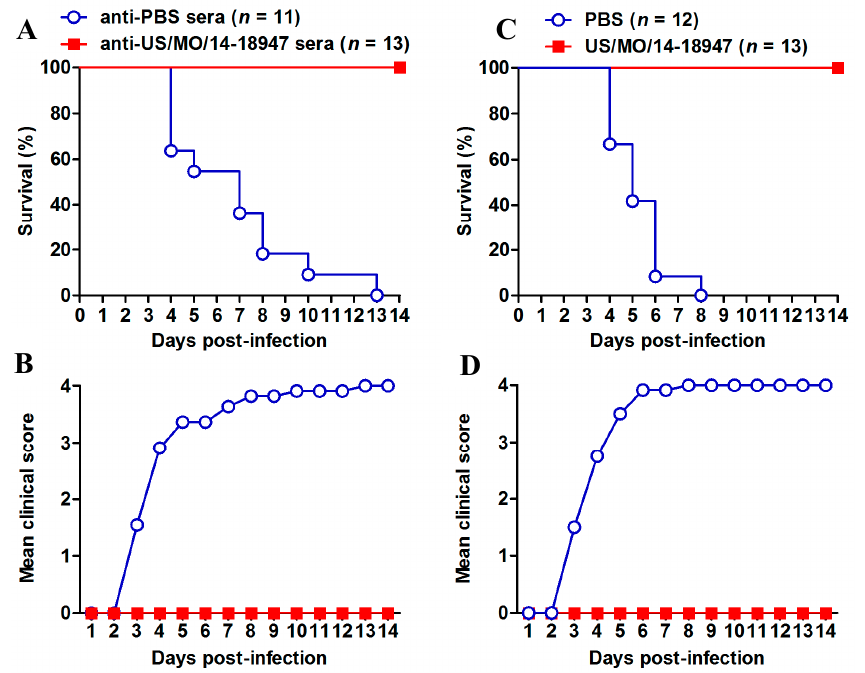
Figure 7. Protective efficacy of inactivated US/MO/14-18947 in the EVD68 infection mouse model. ( A , B ) Passive transfer of anti-US/MO/14-18947 sera conferred complete protection against lethal viral challenge in suckling mice. Groups of ICR mice less than one day of age were i.p. injected with anti-US/MO/14-18947 or anti-PBS sera. One day later, the mice were challenged i.p. with US/MO/14-18947 and then monitored daily for ( A ) survival and ( B ) clinical score for 14 days; ( C , D ) maternal immunization with inactivated US/MO/14-18947 fully protected suckling mice against lethal viral challenge. One-day-old ICR mice born to dams immunized with PBS or inactivated US/MO/14-18947 were infected with US/MO/14-18947, followed by daily observation of ( C ) survival and ( D ) clinical score for 14 days. Clinical scores were graded as described in the legend of Figure 1. The number of mice in each group is indicated in brackets.